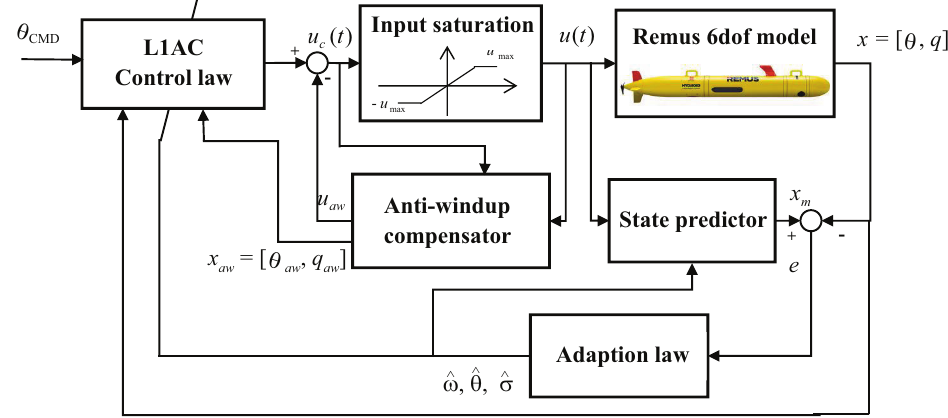
Figure 2. Block diagram of L1AC with AW compensator for REMUS AUV in pitch